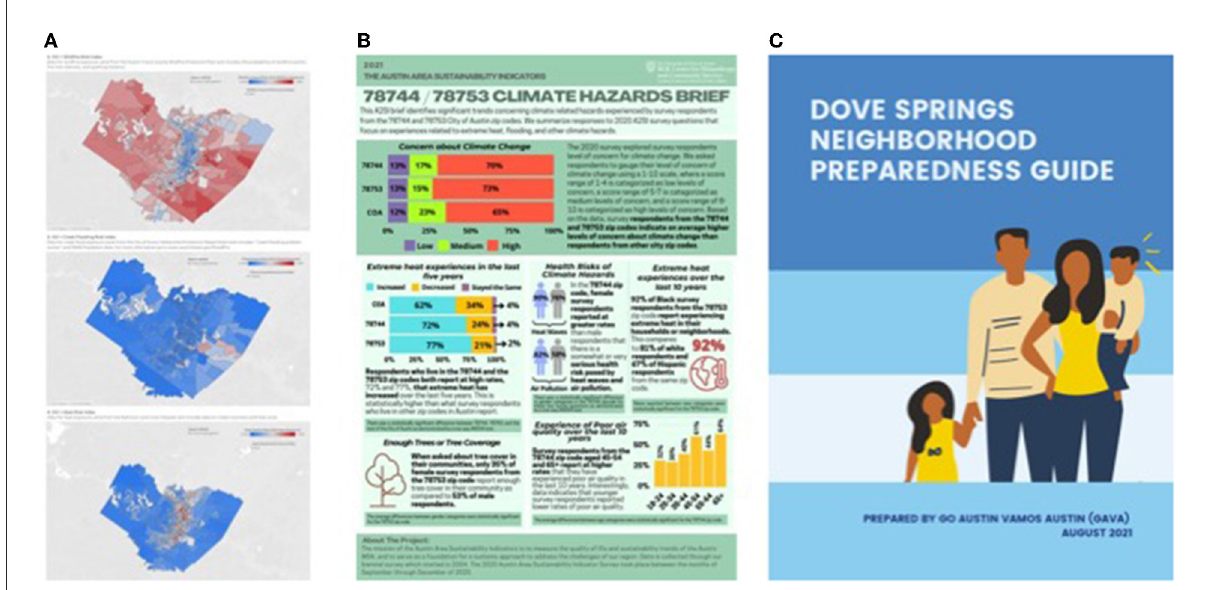
FIGURE1 Three co-production initiatives in Austin: (A) multi-hazard risk mapping, (B) adaptive capacity indicators, and (C) neighborhood preparedness